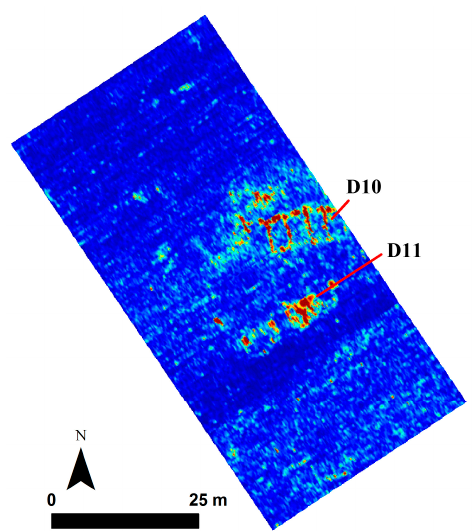
Figure 17. GPR survey results from Perdika 2 at 70–80 cm depth. Reddish colorsindicate high reflectance anomalies.